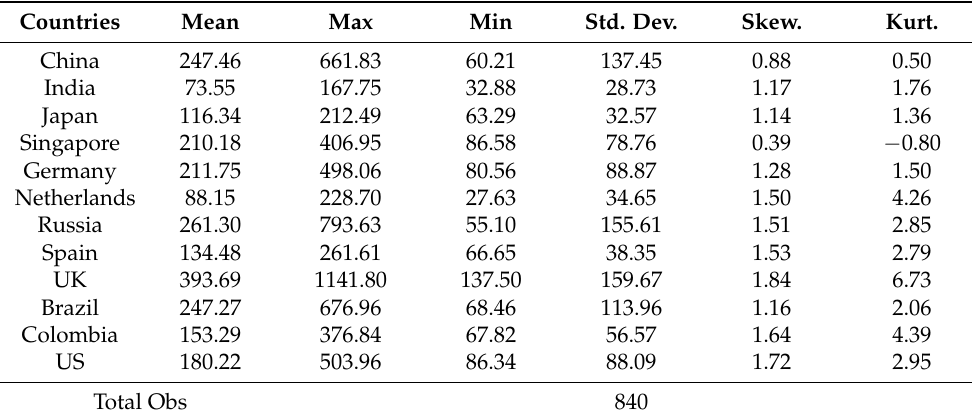
Table 2. Summary statistics of economic policy uncertainty index.